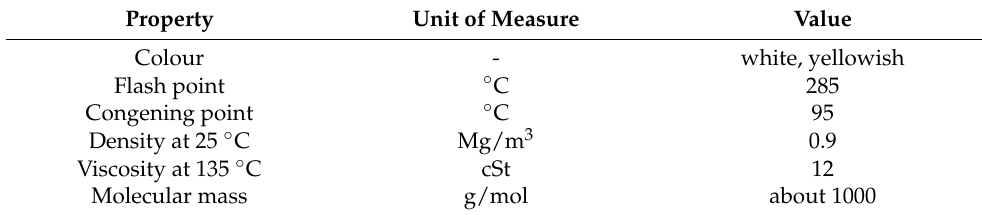
Table 2. Characteristics of the synthetic wax F–T [50,51].